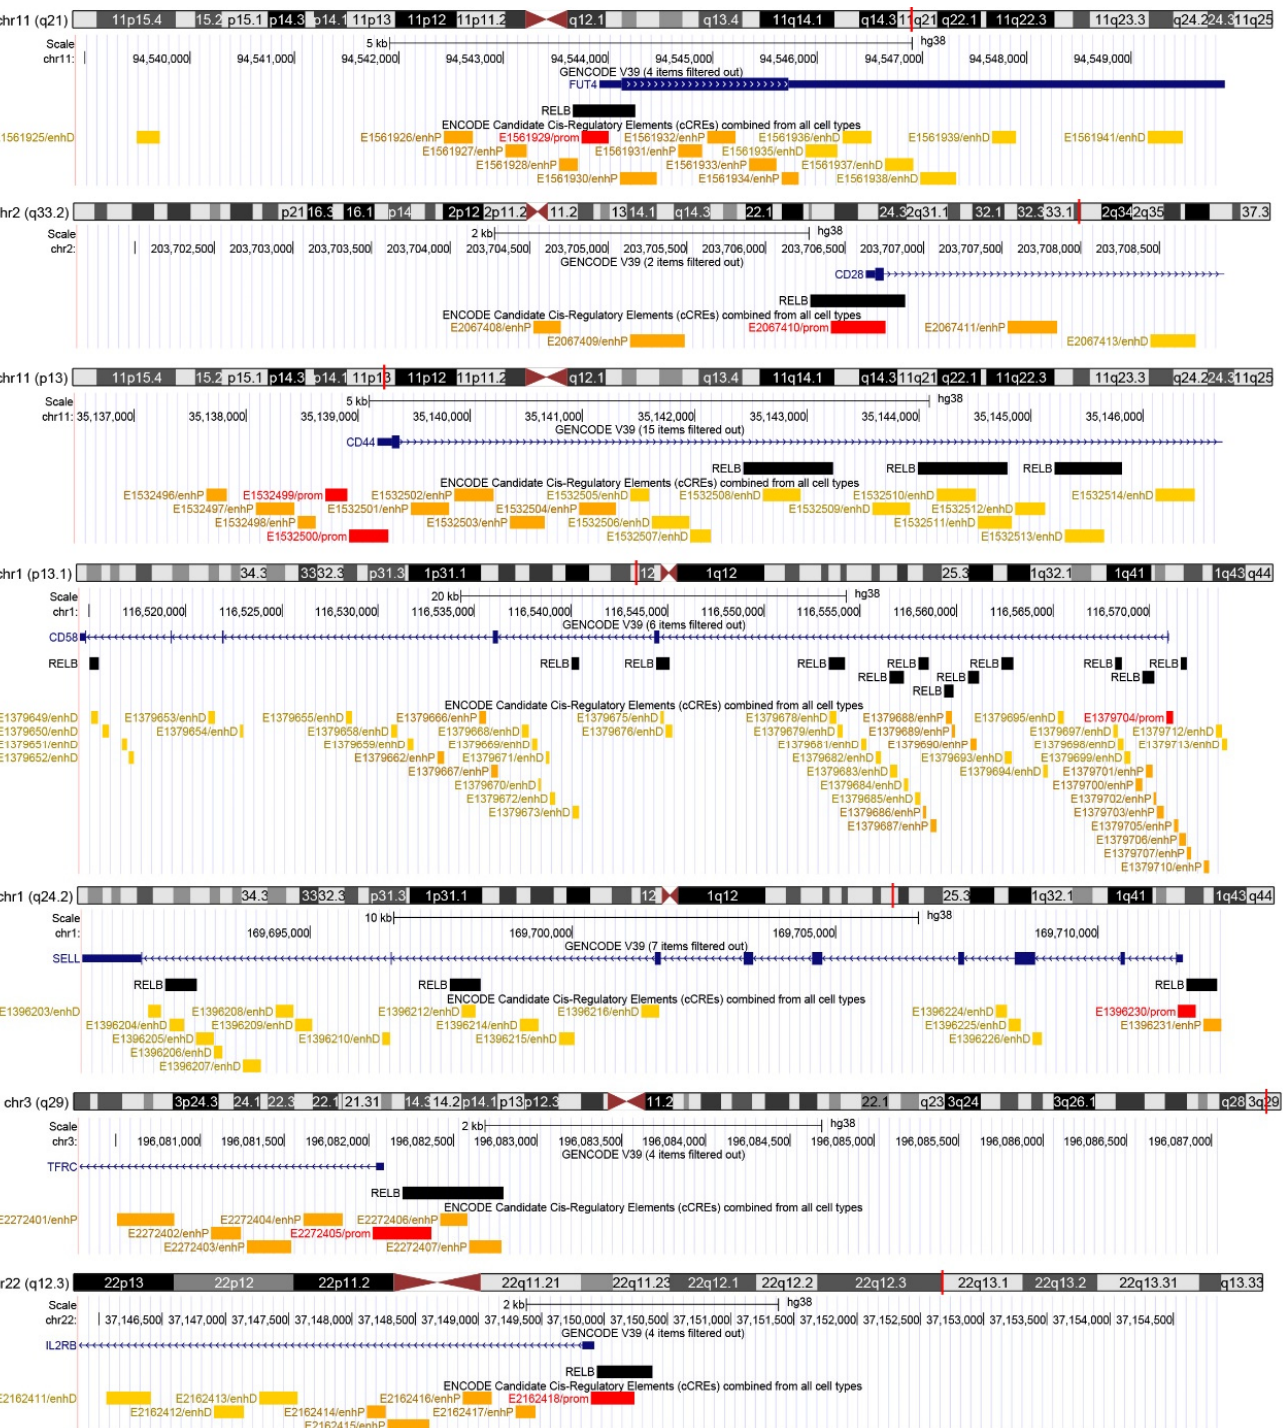
Figure 1. Binding of the NF- κ B subunit RELB in glioma-therapy-associated CD markers. For every CD marker, a chromosome ideogram with chromosomal band location is shown as a vertical red line. Below each chromosome ideogram, parallel lines depict a chromosomal scale, the exact location of each gene transcriptional start site (based on GENCODE V39), and the positions of respective RELB binding sites and ENCODE candidate cis-regulatory elements.